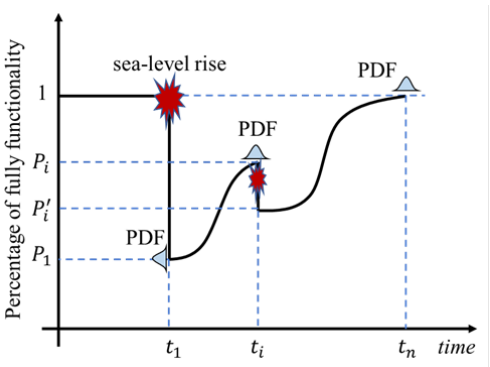
Figure 8. Resilience assessment of coastal cities affected by disasters related to sea-level rise (revised form Xiong and Huang [149]).